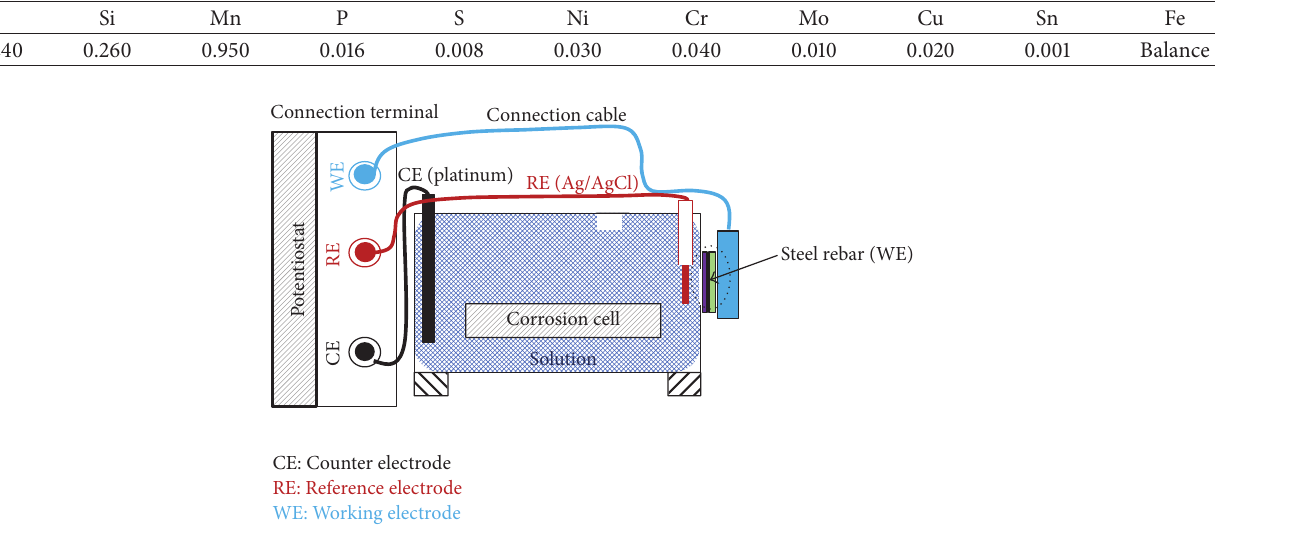
Figure 1: Schematic diagram of electrochemical cell [36, 37].